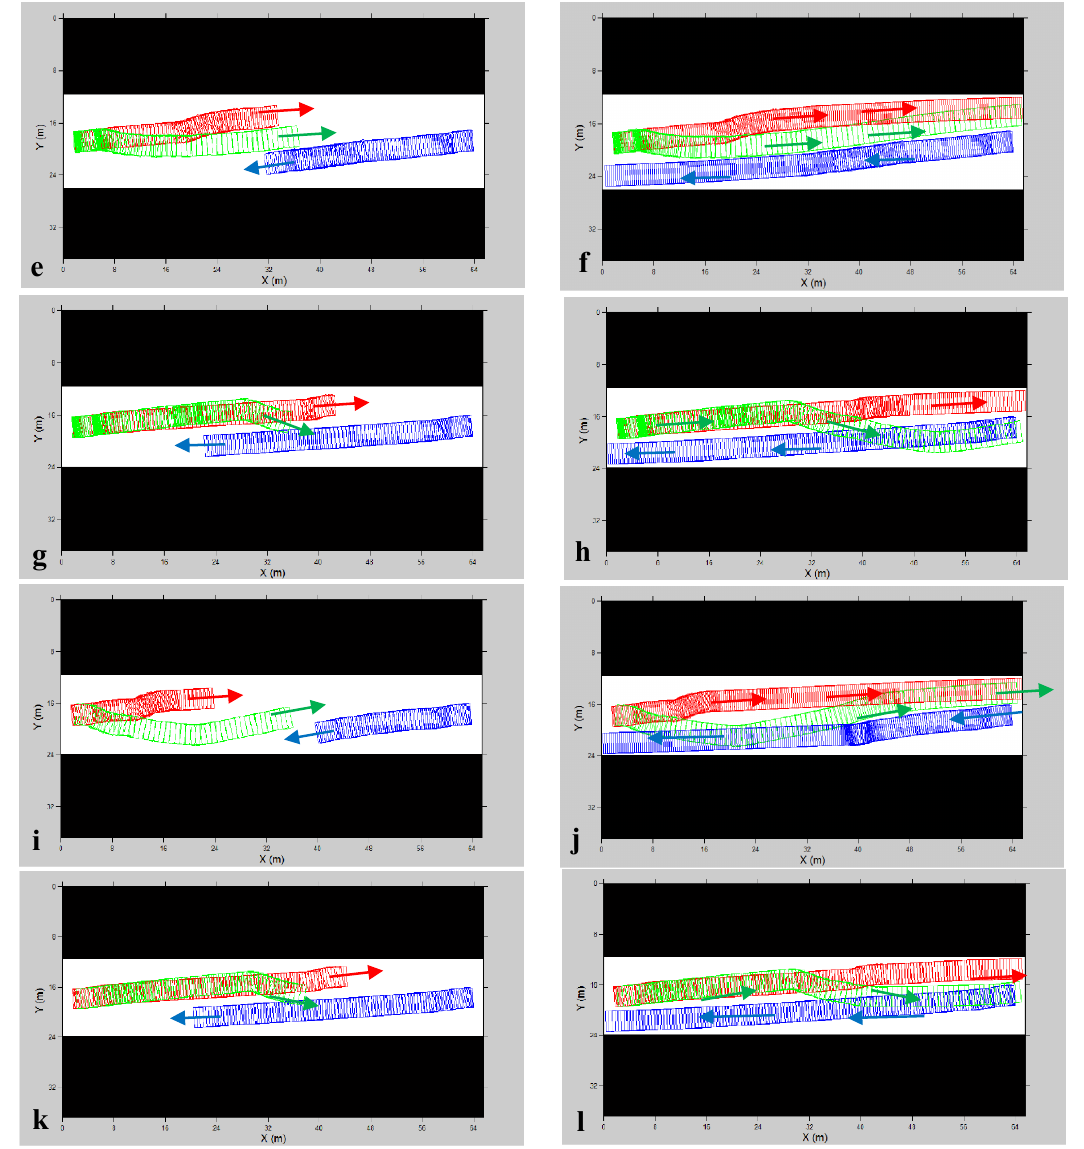
Figure 12. Simulation results in overtaking scenarios. ( a ) Vehicle following scenario (midway); ( b ) Vehicle following scenario (end of simulation); ( c ) Two vehicle overtaking scenario (midway); ( d ) Two vehicle overtaking scenario (end of simulation); ( e ) Scenario with enough road width to host 3 vehicles (midway); ( f ) Scenario with enough road width to host 3 vehicles (end of simulation); ( g ) First infeasible overtaking scenario (midway); ( h ) First infeasible overtaking scenario (end of simulation); ( i ) Feasible overtaking scenario (midway); ( j ) Feasible overtaking scenario (end of simulation); ( k ) Second infeasible overtaking scenario (midway); ( l ) Second infeasible overtaking scenario 2 (end of